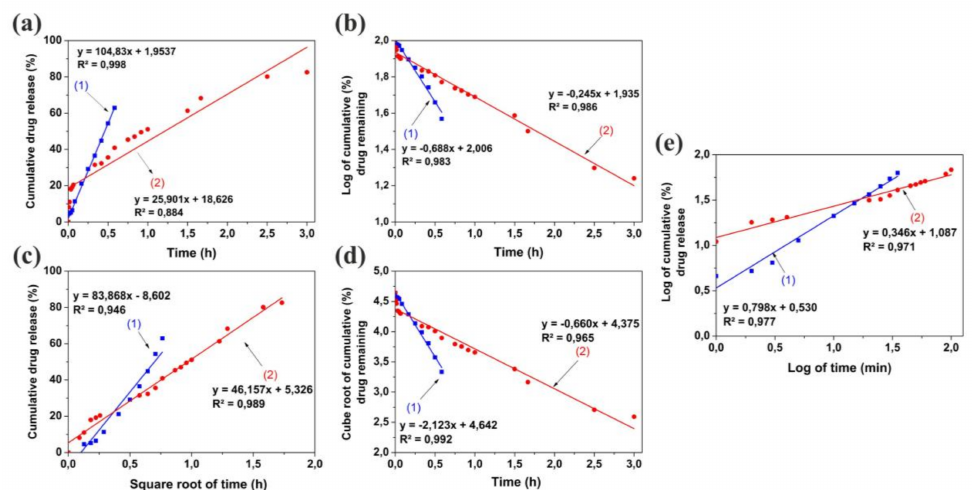
Figure 8. Kinetics study for the release of triclosan from CNC_TR(1) and CNC_TiO 2 _TR(2): Zero order ( a ); First order ( b ); Higuchi ( c ); Hixon–Crowell ( d ) and Korsmeyer–Peppas ( e ) kinetic